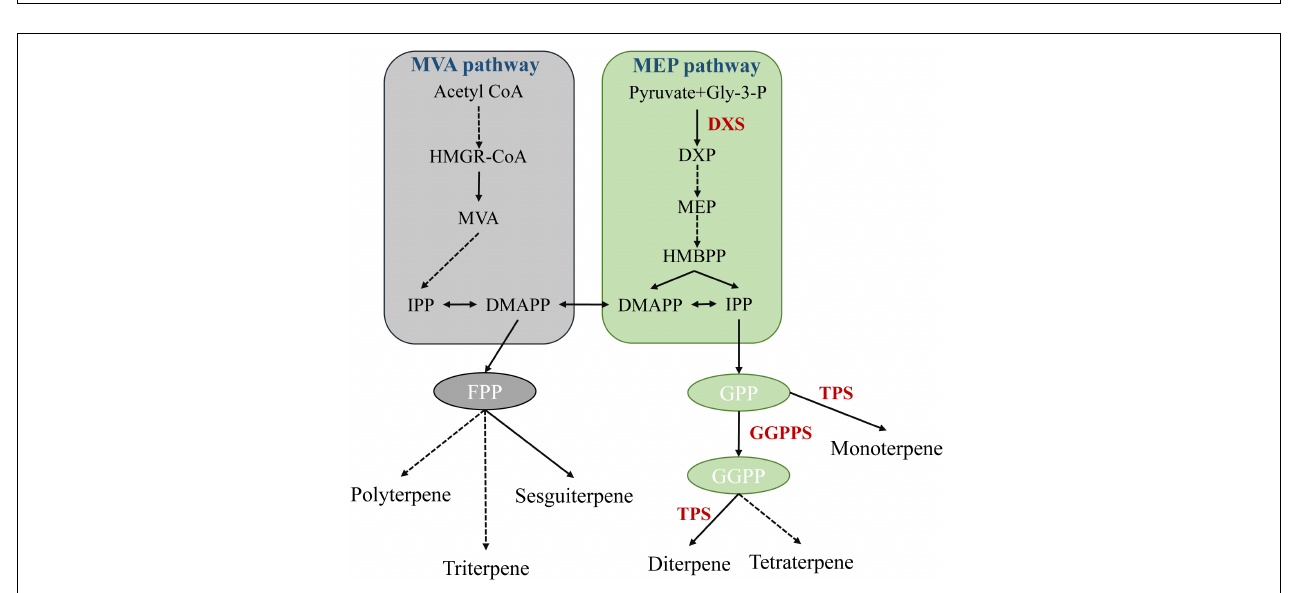
FIGURE 4 | Functional and pathway enrichment analysis of expanded genes in A. tsao-ko . (A) GO enrichment analysis of expanded genes in A. tsao-ko . (B) KEGG enrichment analysis of expanded genes in A. tsao-ko .